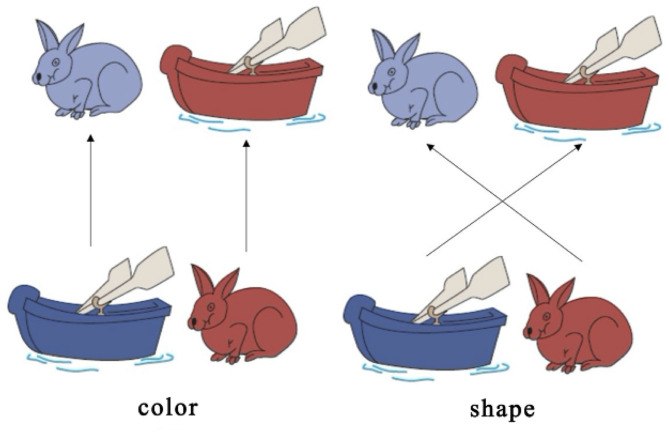
Dimensional Change Card Sort (DCCS) task Zelazo (2006).